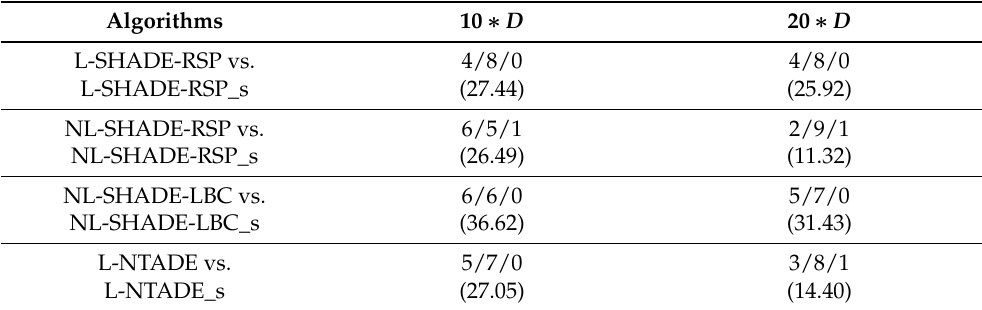
Table 3. Algorithms with and without crossover rate sorting, CEC 2022, Mann–Whitney tests and total standard score.